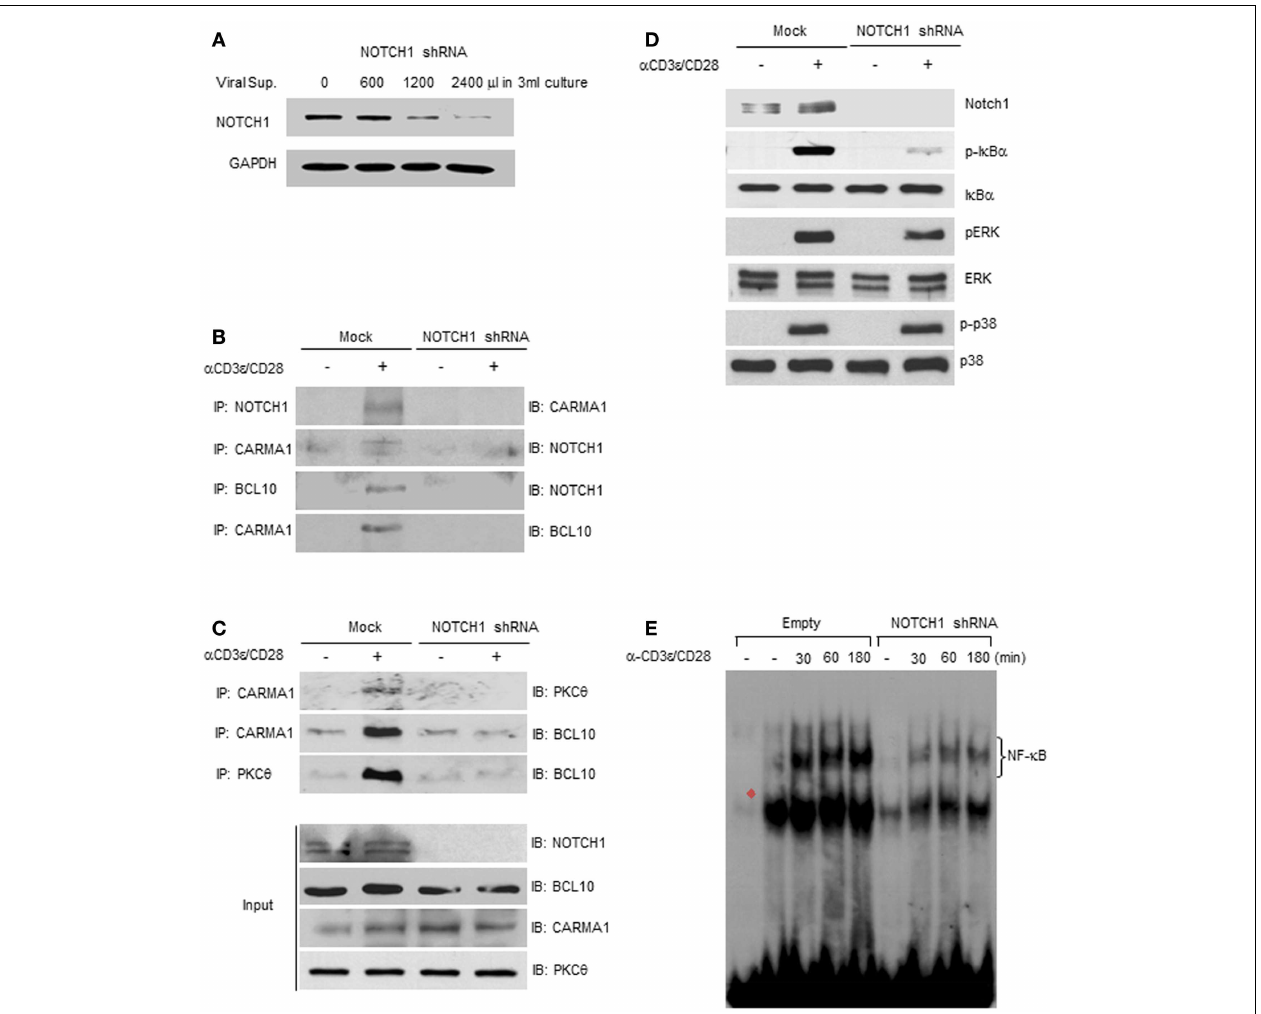
with (D) antibodies specific for NOTCH1, phosphorylated and total I κ B α , phosphorylated and total ERK, and phosphorylated and total p38 MAPK. (E) NOTCH1-knock-down JurkatT cells, or mock-infected control cells, were stimulated with plate-bound anti-human CD3 ε and anti-human CD28 for the times indicated. EMSAs were performed on nuclear extracts using radiolabeled oligonucleotides containing the NF- κ B binding sequence. Red filled diamond represents competition with cold probe. Data are representative of at least three independent